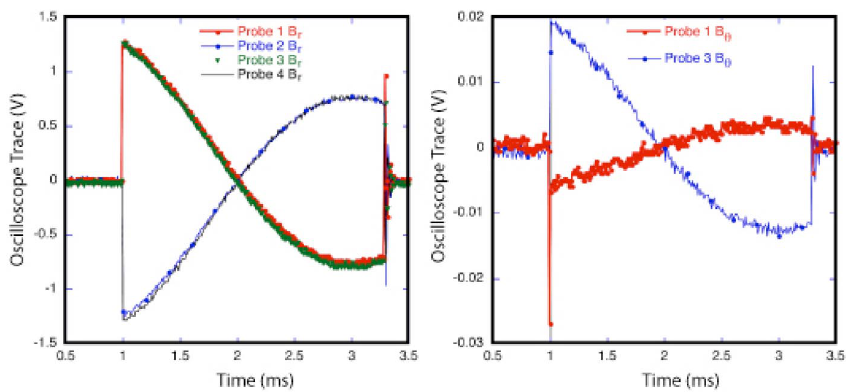
FIG. 21. (Color) Oscilloscope traces of the probe output when the supporting cylinder is rotated to place probes at the center of the quadrupole windings. The left traces are from loops oriented to sense radial flux, and the right traces are from loops sensing azimuthal